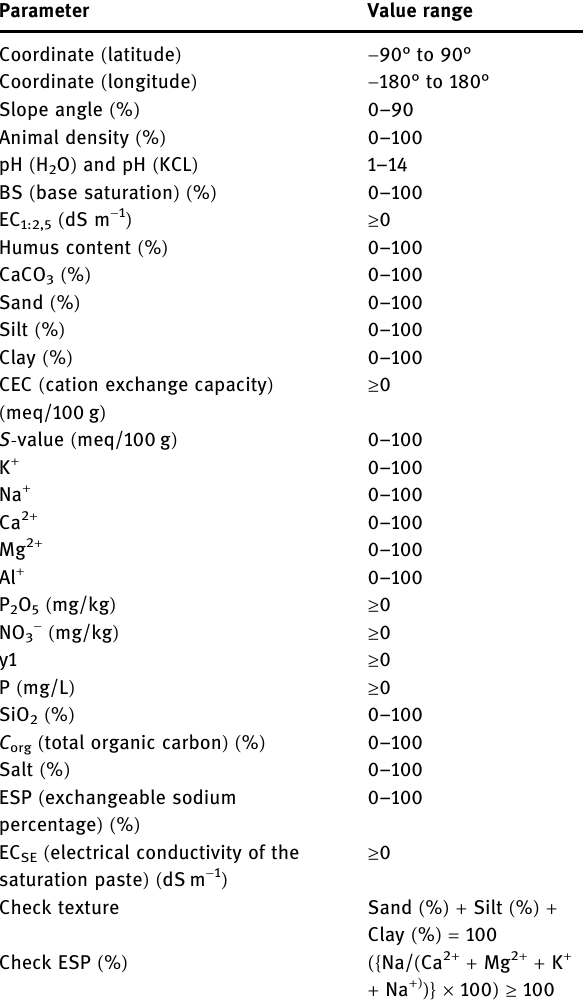
Table 4: List of value ranges of input data